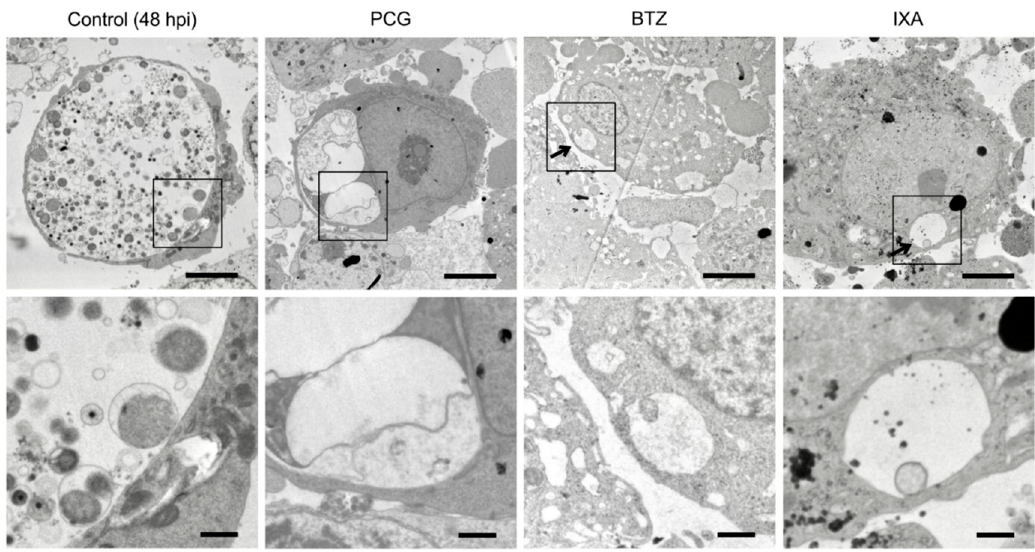
Figure 4. EM analysis of BTZ-treated chlamydial inclusions. ( Top ) C. trachomatis L2-infected HeLa cells were separately incubated with BTZ or IXA (1 µ M each) or 5 units/mL PCG. All cell samples cells were separately incubated with BTZ or IXA (1 μ M each) or 5 units/mL PCG. All cell samples were harvested at 48 hpi and analyzed by EM (magnification, × 2000). Arrows denote chlamydial were harvested at 48 hpi and analyzed by EM (magnification, ×2000). Arrows denote chlamydial inclusion. Scale bar, 5 µ m. ( Bottom ) High-magnification image of each black square area. Scale bar, inclusion. Scale bar, 5 μ m. ( Bottom ) High-magnification image of each black square area. Scale bar, 1 μ m. 1 µ